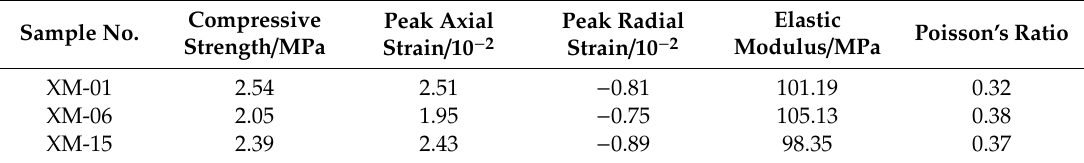
Table 4. Uniaxial compression test results.